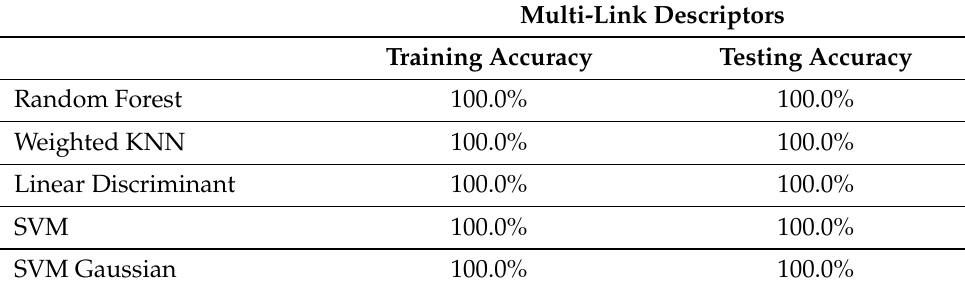
Table 7. Accuracy rate for model with multi-link descriptors